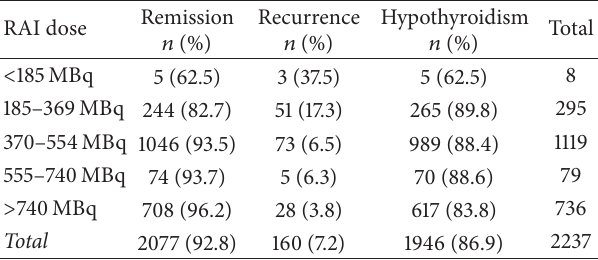
Table 3: Outcome after different RAI dose.